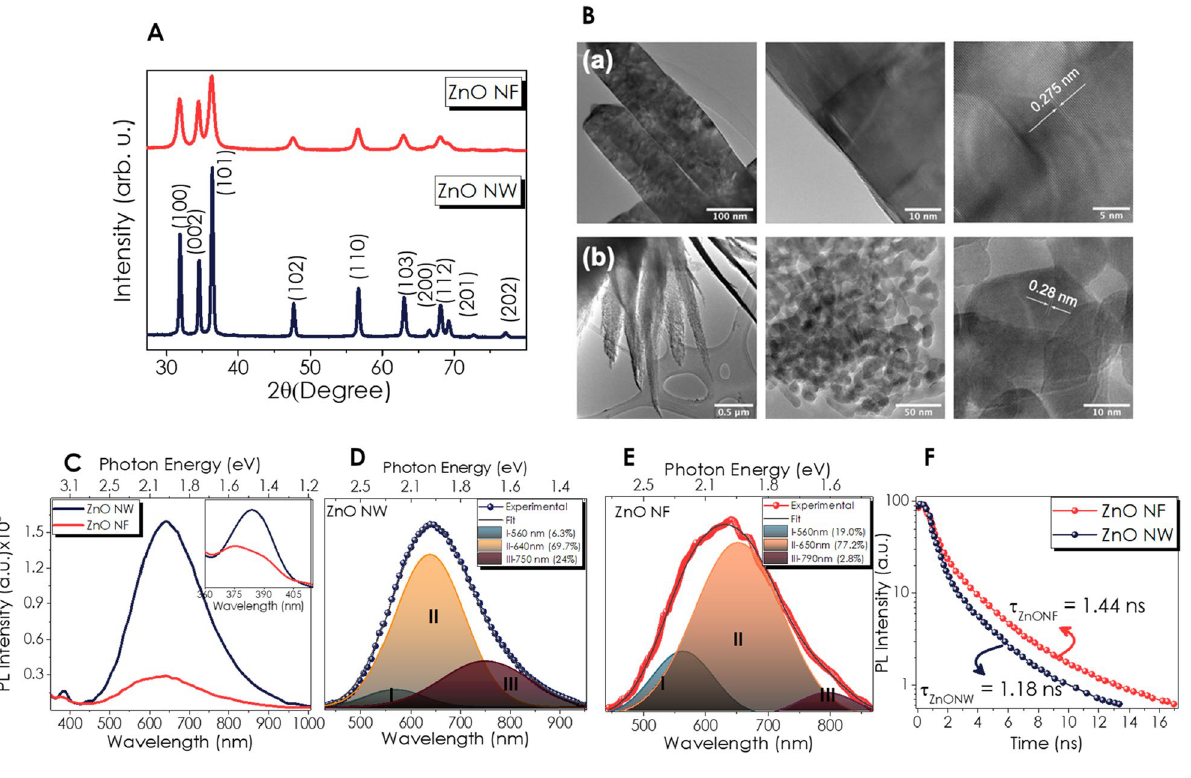
Figure 1. ( A ) XRD patterns; ( B ) TEM and HRTEM ( a ) NW and ( b ) NF; normalized PL spectra ( C ) Comparison of NF and NW, deconvoluted DLE of ( D ) NW, ( E ) NF powder; ( F ) Tr-PL